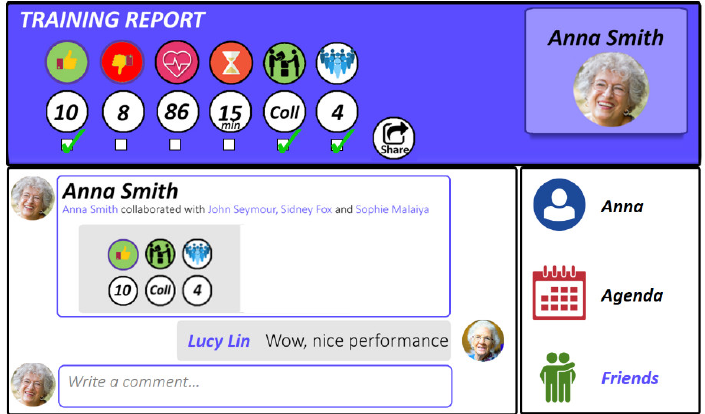
Figure 8. A screenshot of the SocialBike SMN. The user (Anna) can choose which data can be seen by her friends when sharing her performance, and manage her personal data, her agenda, and her friends’ list.